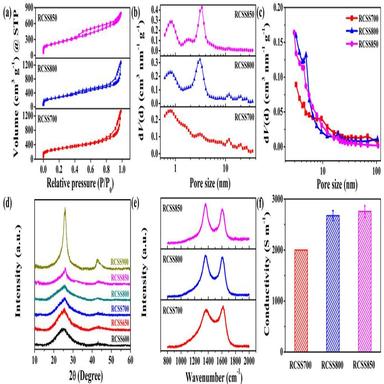
Physical characterization of RCSSs. (a) N2 adsorption/desorption isotherms of RCSSs. Pore size distribution calculated from the (b) DFT method, (c) BJH method. (d) XRD patterns. (e) Raman spectra. (f) Electrical conductivities determined by four-probe method.